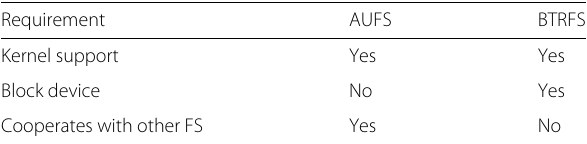
Table 1 Requirements of AUFS and